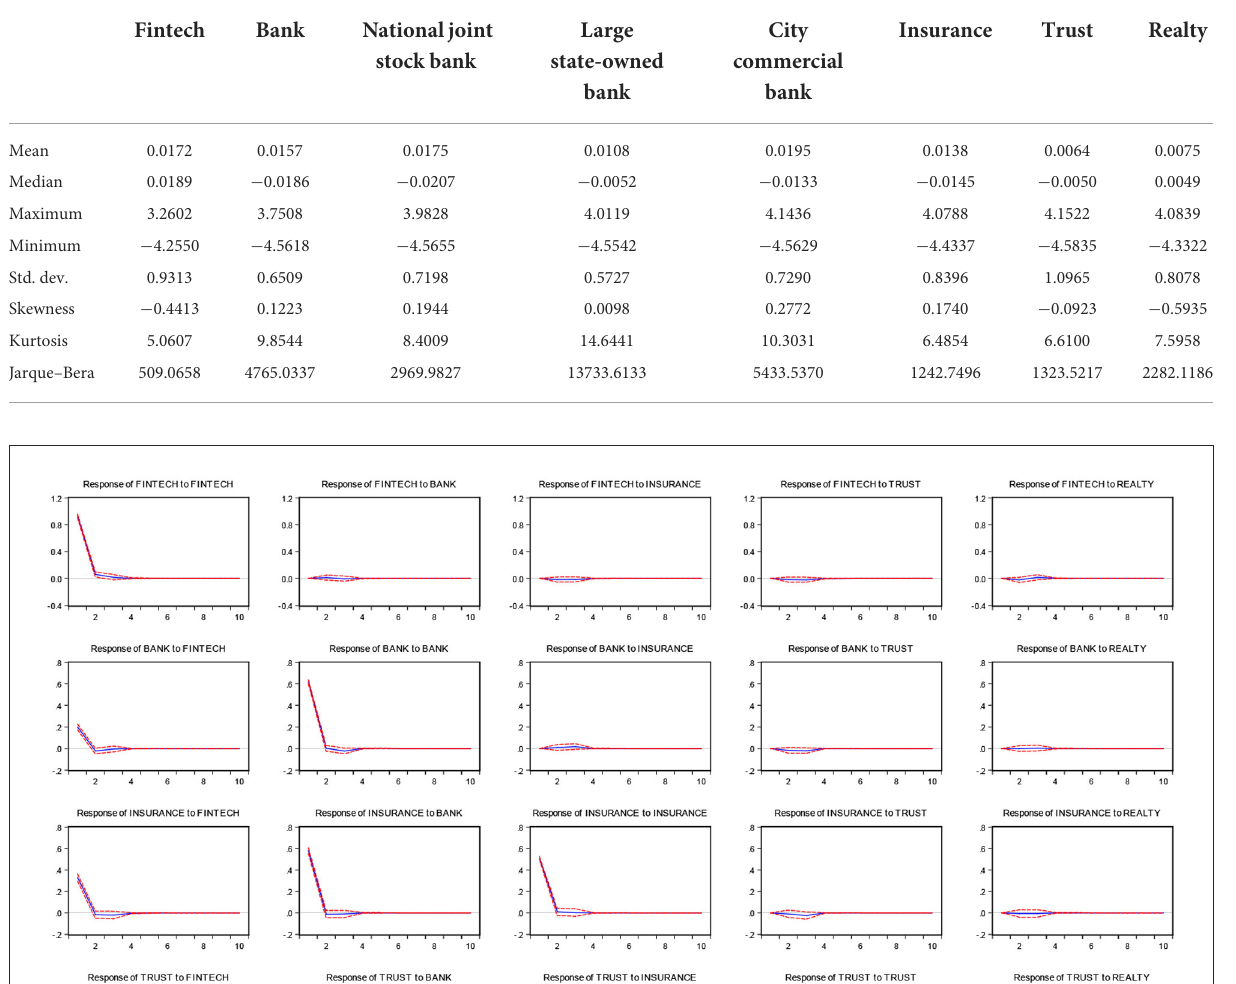
FIGURE1 Impulse response analysis.